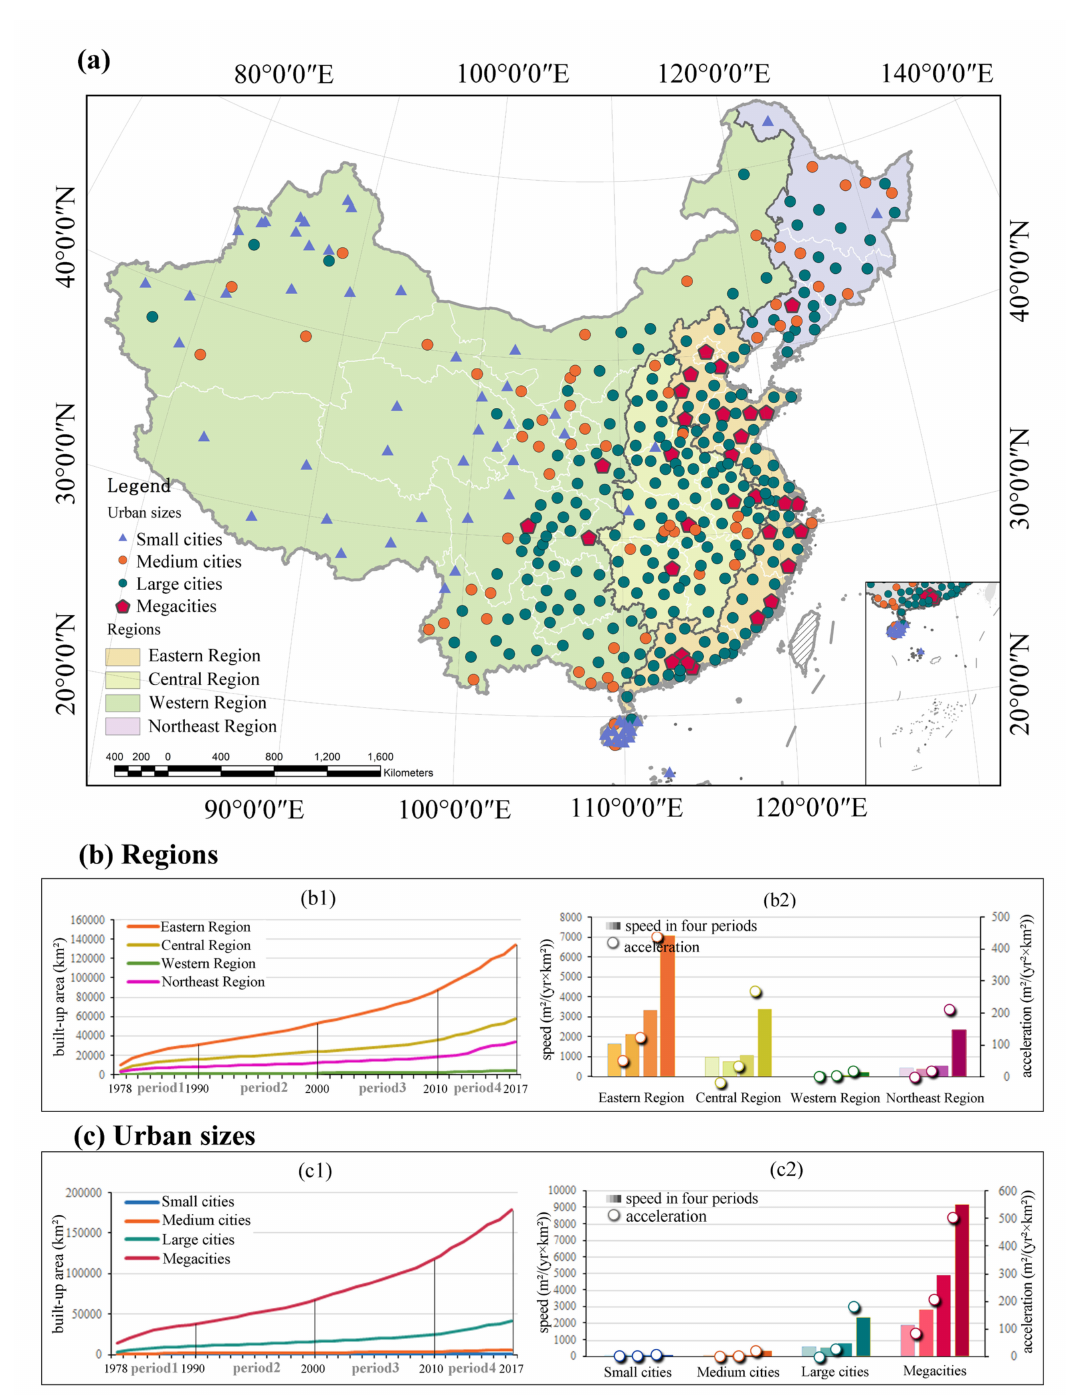
Figure 7. Sample city identification and built-up area expansion: ( a ) sample city identification of di ff erent regions and urban sizes; ( b ) di ff erences in built-up area expansion by region, based on comparison of built-up area, speed, and acceleration; ( c ) di ff erences in built-up area expansion according to urban size, based on comparison of built-up area, speed, and